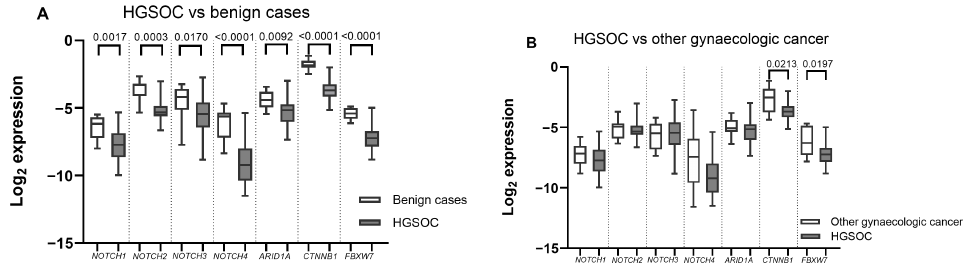
Figure 2. mRNA levels in ovarian cancer tissues. ( A ) gynaecologic cancer (n = 42) vs. benign cases (n = 9) ( B ) high-grade serous ovarian cancer (HGSOC) (n = 32) vs. other gynaecologic cancer cases (n = 10). Boxes indicate the log 2 normalized expression data. Whiskers denote minimum and maximum values.